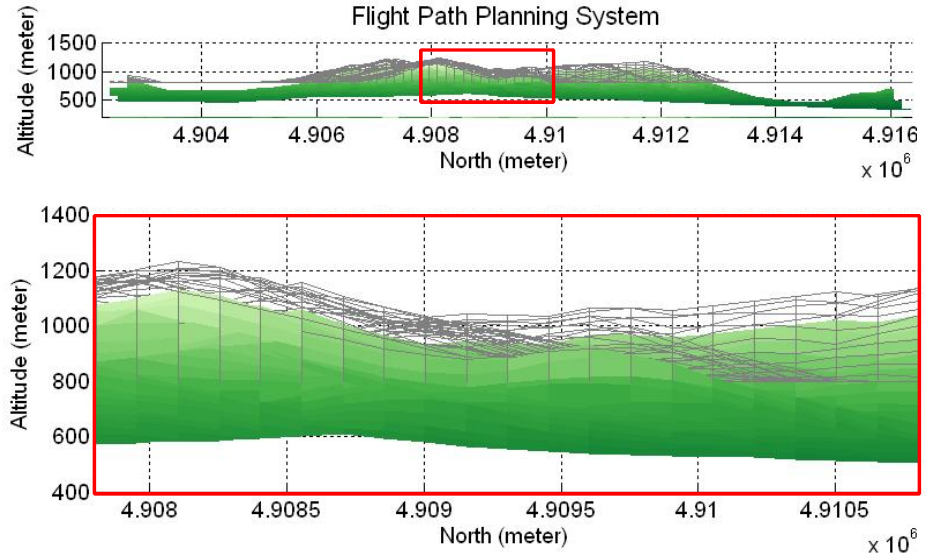
Figure 2. The virtual flight map is created above the real